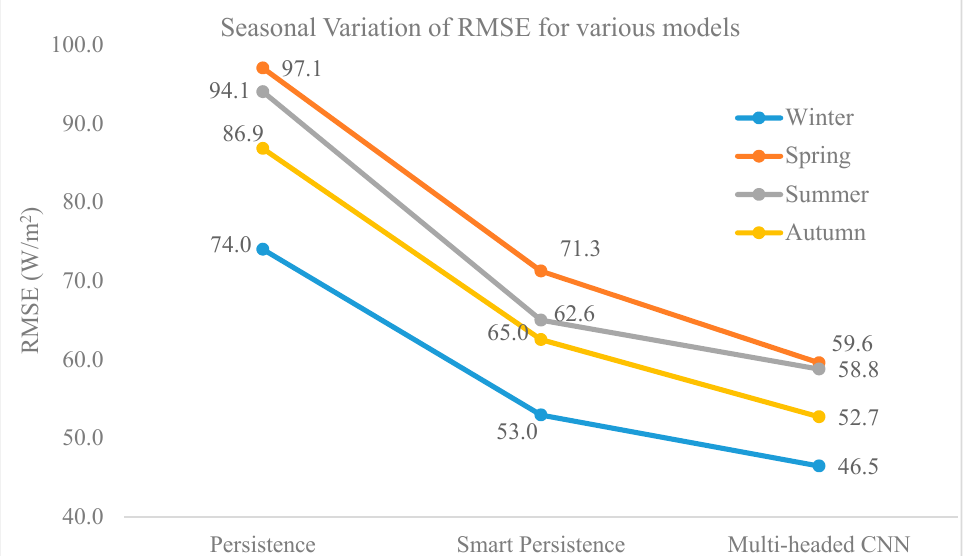
Figure 12. Seasonal variation of RMSE for forecasting solar irradiance.